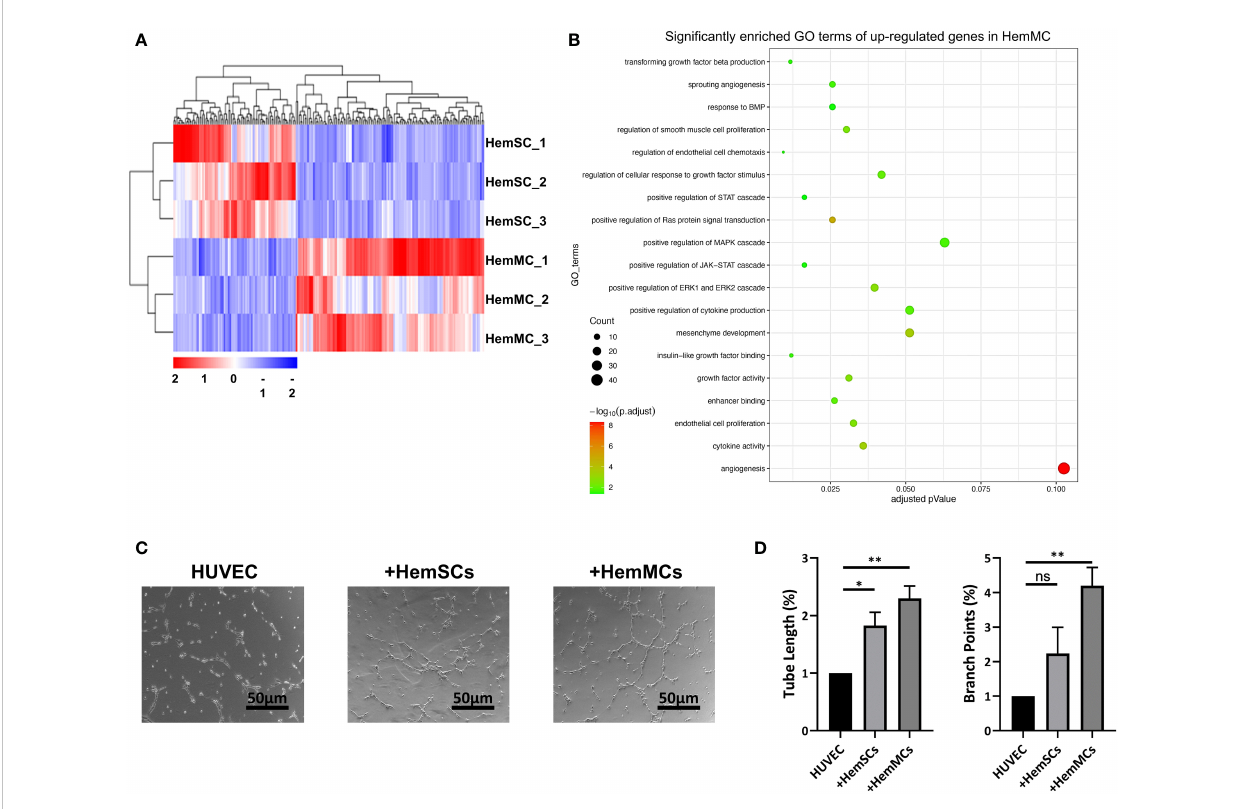
FIGURE 5 HemMCs display pro-angiogenesis capacity. (A) Heatmap showing the transcriptional expression pro fi les of HemMCs and HemSCs. (B) GO enrichment analysis of the differentially expressed genes (the upregulated ones in HemMCs). (C) Representative images of tube formation on Matrigel in vitro by HUVECs cultured alone, cocultured with HemSCs, or cocultured with HemMCs. Scale bars=50 m m. (D) Semiquantitative analysis of the tube length and number of branch points of HUVEC tubes. ImageJ and GraphPad Prism software were used for analysis. *, p <0.05; **, p <0.01; ns, p>0.05. HemMCs, infantile hemangioma mural cells; HemSCs, infantile hemangioma stem cells; GO, gene ontology; HUVECs, human umbilical vein endothelial